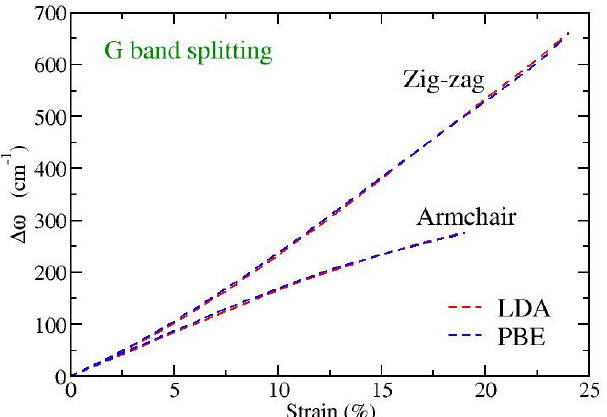
Figure 5. Strain dependence of the G-band splitting, ∆ ω = ω + − ω − , for strains along the armchair and zigzag directions, as obtained by DFT calculations at the level of LDA/PZ (red) and GGA/PBE (blue) functionals.